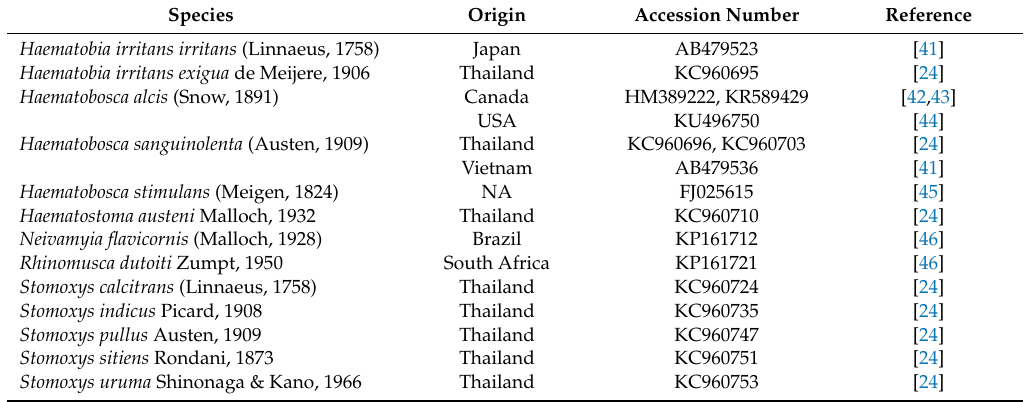
Table 1. Stomoxyine flies from the GenBank database used for constructing the phylogenetic